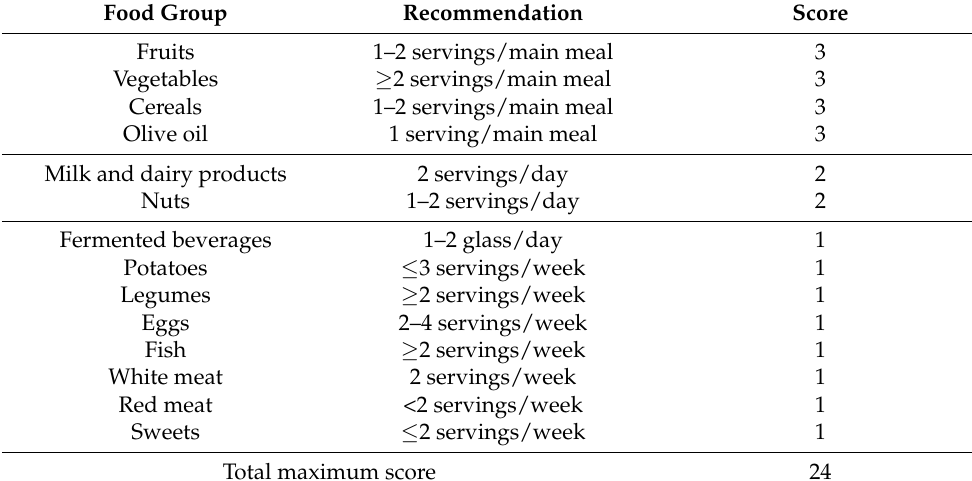
Table A3. Mediterranean diet Serving Scores (MDSS). Food